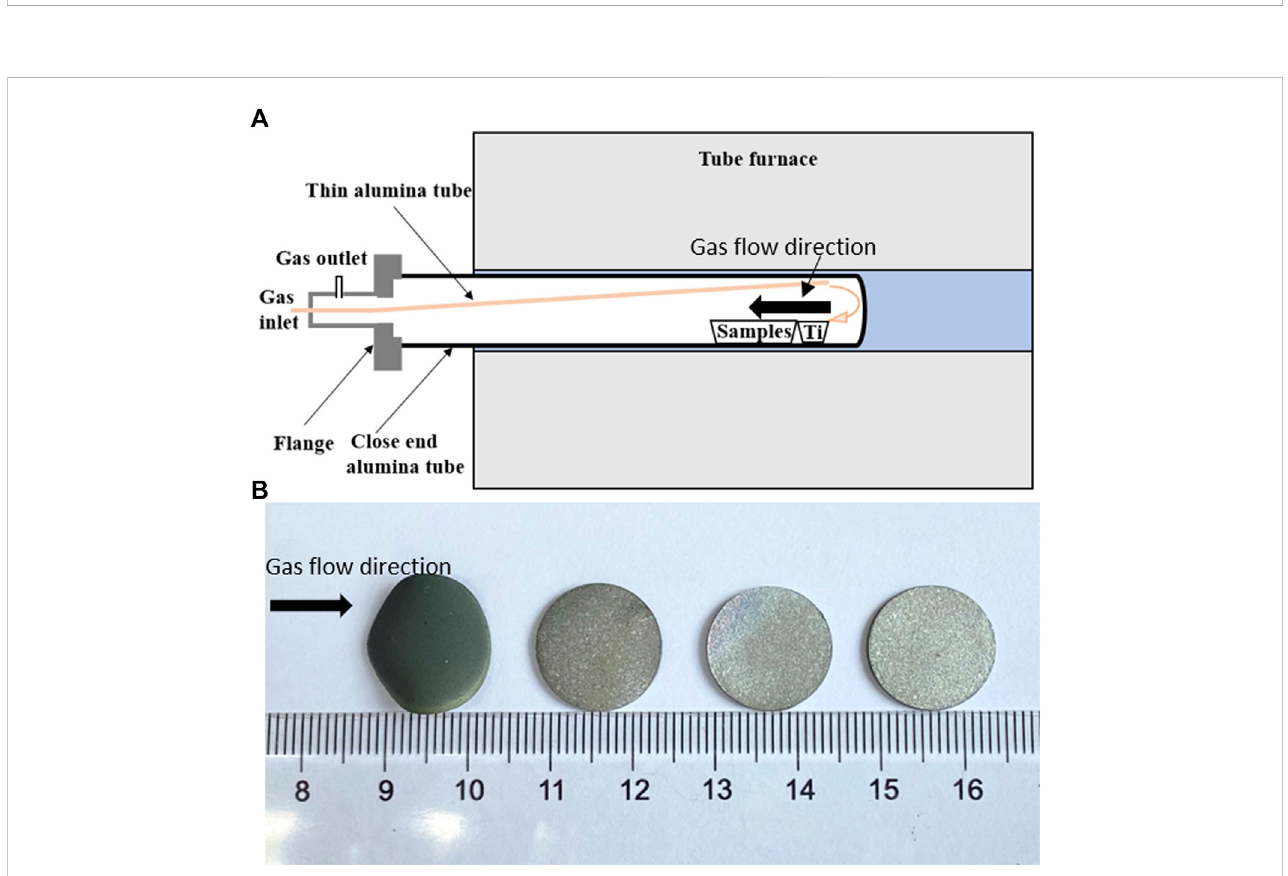
FIGURE 4 Illustration of the samples sintered under the puri fi ed 5% H 2 /Ar gas mixture at 1350 ° C for 3 h: (A) schematic showing the gas fl ow direction and the relevant position between titanium fi lms and samples; (B) photographs showing the samples after sintering. The raw materials contain 24 wt.% starch (based on SS430L). Note that other than in this test, other samples in this study are sintered in an alumina tube with two open ends, where titanium fi lms were also added in the same sample